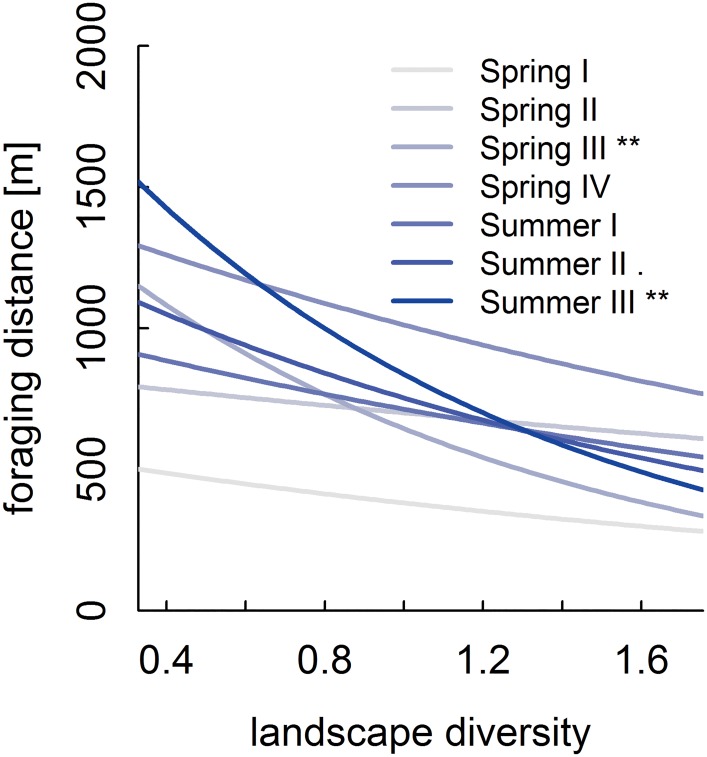
Pollen foraging distances of honey bees in relation to landscape diversity.Data were collected based on observation of waggle dances in eight observation rounds in 16 landscapes. Slopes significantly different from zero: · P < 0.1; ** P < 0.01. For the distribution of sampling dates, see Fig 1.